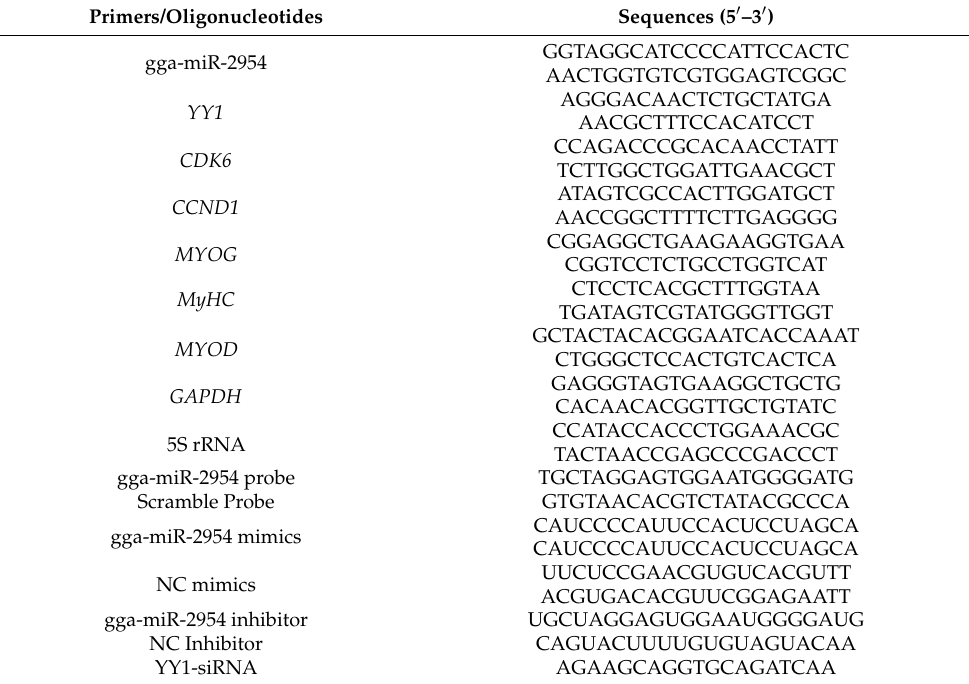
Table 1. Related primers used in Q-PCR.